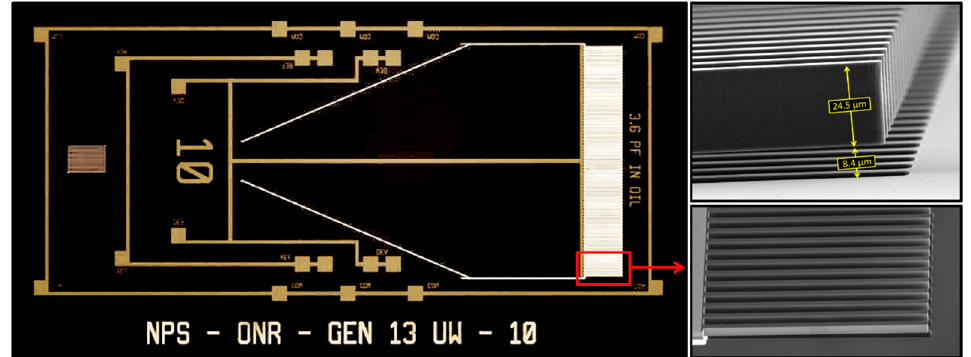
Figure 3. Photograph of the fabricated underwater sensor (left side) with expanded view (SEM micrograph) of the comb finger capacitors used for electronic readout of the signal. Note that the fingers from the sensor do not overlap with the fingers from the substrate due to the residual stress generated in the fabrication process.